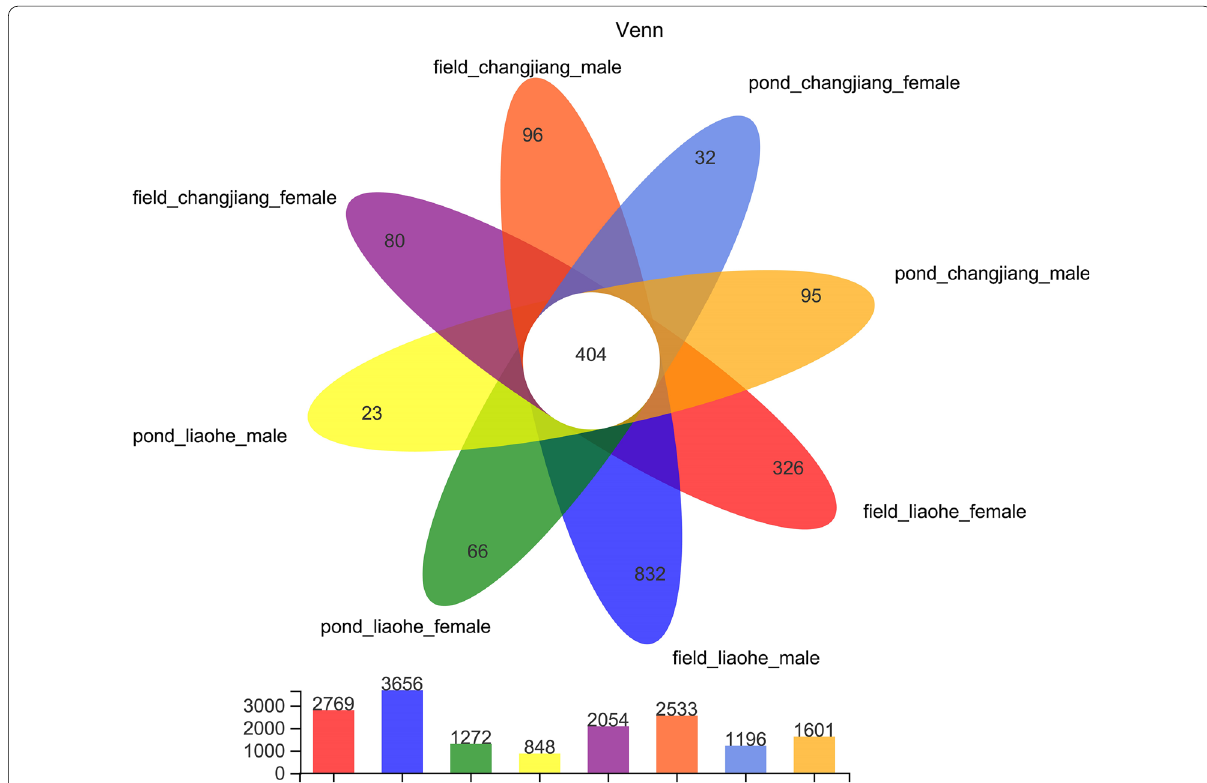
Fig. 3 Venn diagram showing that core bacterial OTUs dominated the intestines of crabs, except for the Liaohe variety cultured in rice fields. The latter had more exclusive OTUs than crabs in the other sample groups. Field and pond, intestinal bacteria in Chinese mitten crabs raised in rice fields and aquaculture ponds; Liaohe and Changjiang, two varieties of Chinese mitten crab